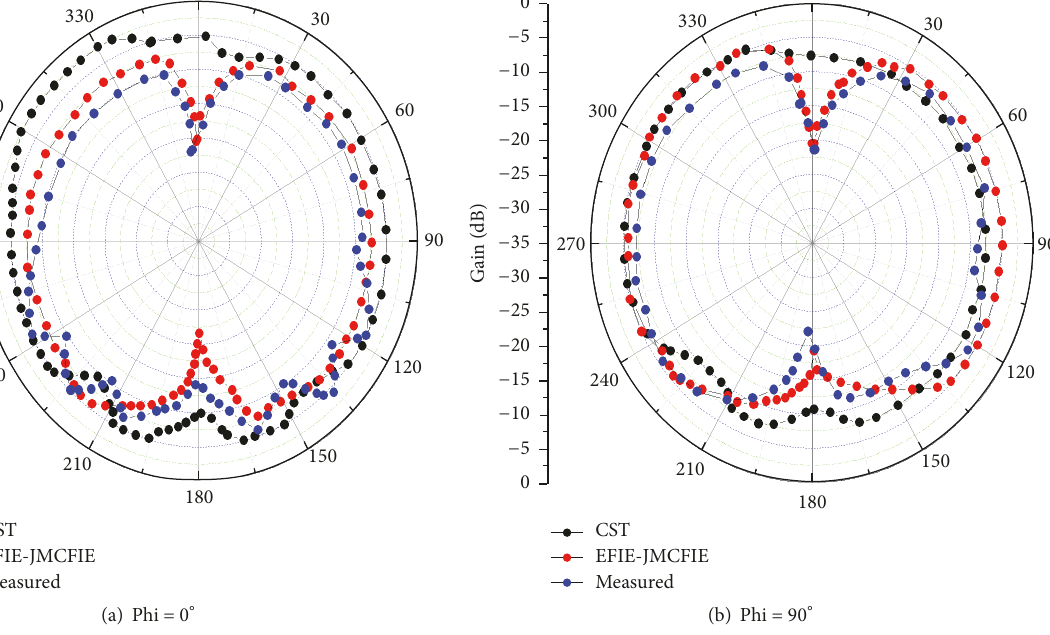
Figure 17: Radiation pattern of UAV.